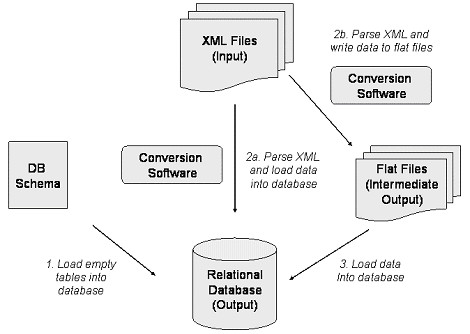
MEDLINE database development process. In Step 1, the user loads the schema, creating empty tables in the database. In Step 2, the conversion software parses the XML files and either loads the data directly into the database (2a), or writes the data out to intermediate text files (2b). If intermediate text files are generated, data from those files are loaded into the database as a separate step in Step 3.